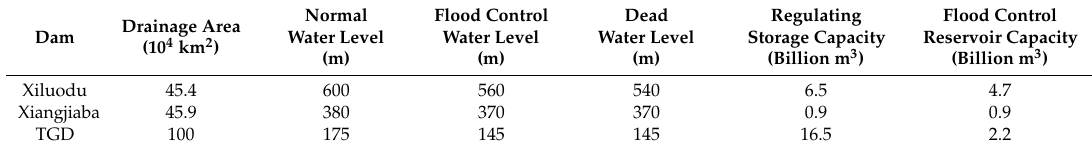
Table 1. Characteristics of the Xiluodu, Xiangjiaba and Three Gorges Dam